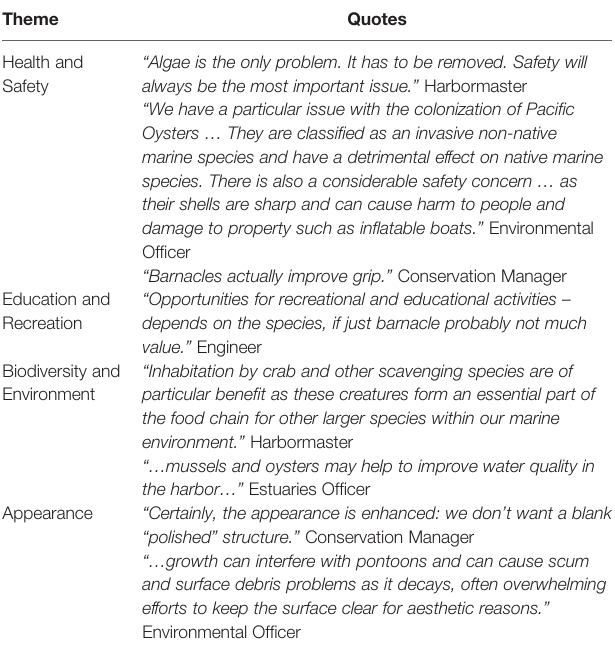
TABLE 7 | Illustrative quotes concerning the perceived advantages and disadvantages of marine growth.